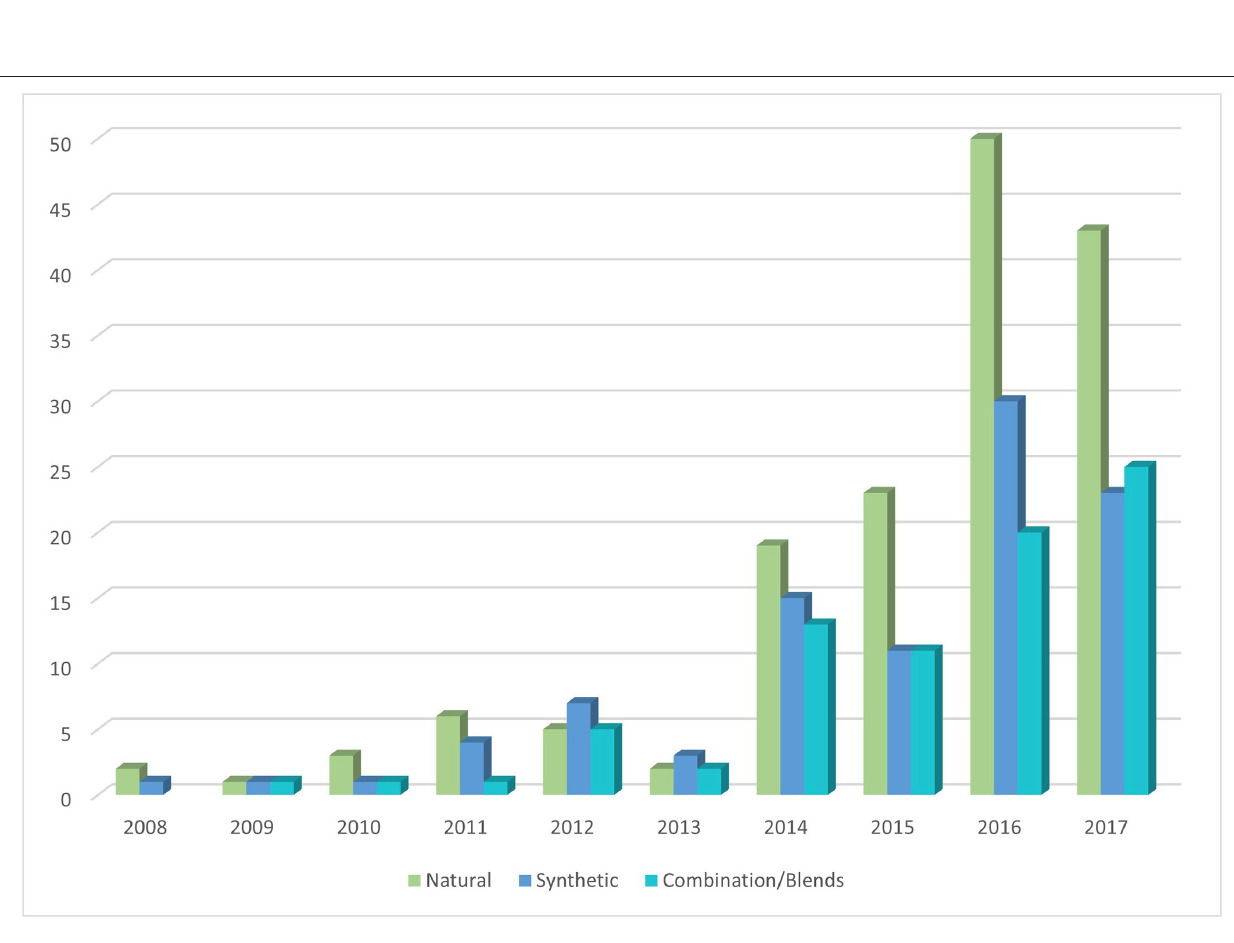
FIGURE 4 | Bioink type frequency in relation to the year of